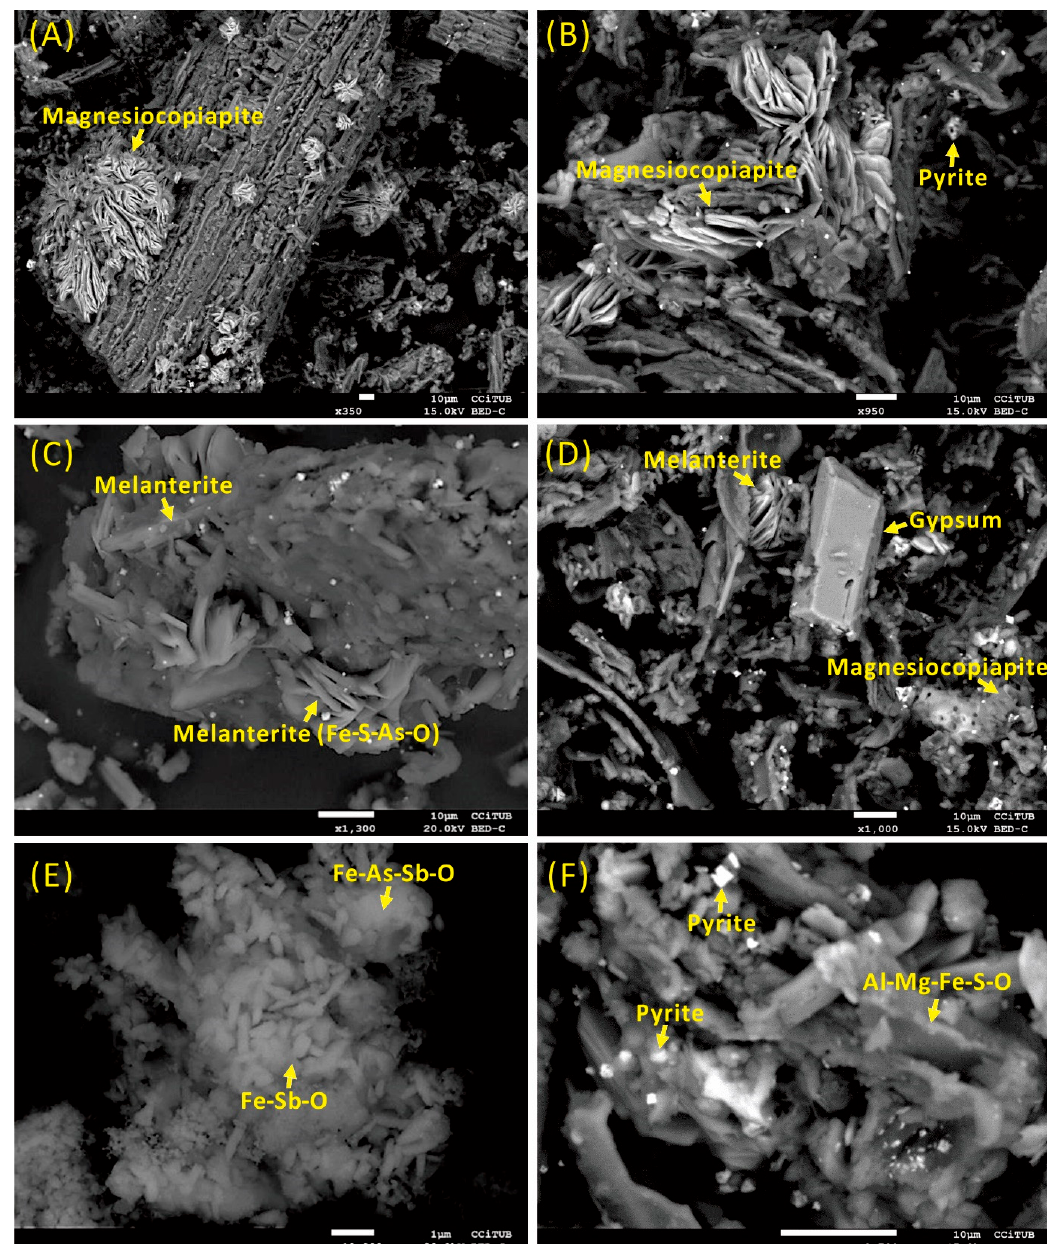
Figure 8. SEM back-scattered electron images of coalified trunk samples from Wulantuga open-pit mine. ( A ), magnesiocopiapite in sample WLTG-03. ( B ), magnesiocopiapite and pyrite in